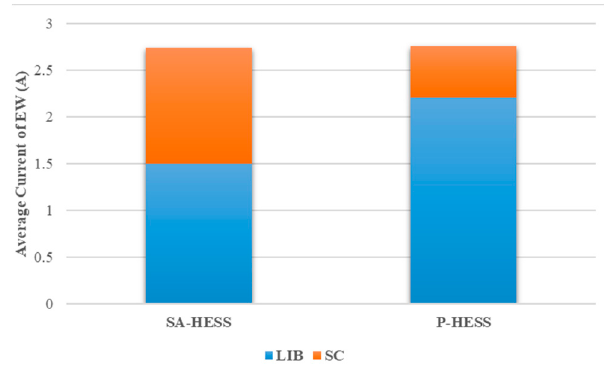
Figure 15. Comparison of the proposed semiactive (SA)-HESS and P-HESS.